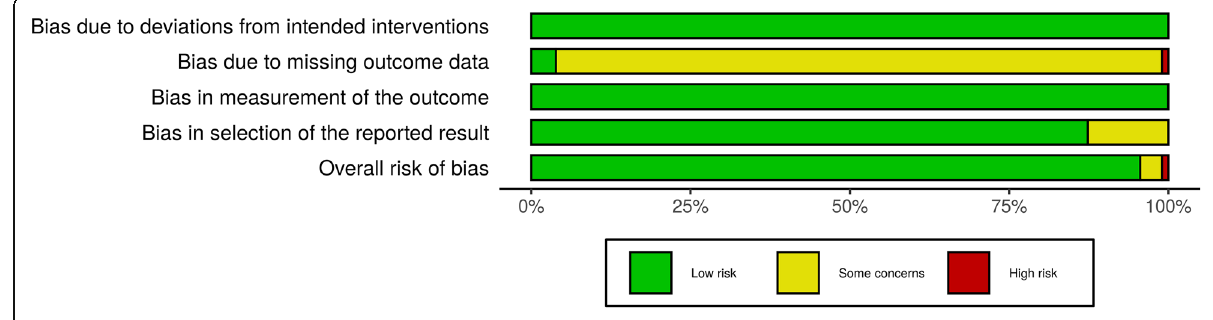
Fig. 3 Risk of bias assessment in the included